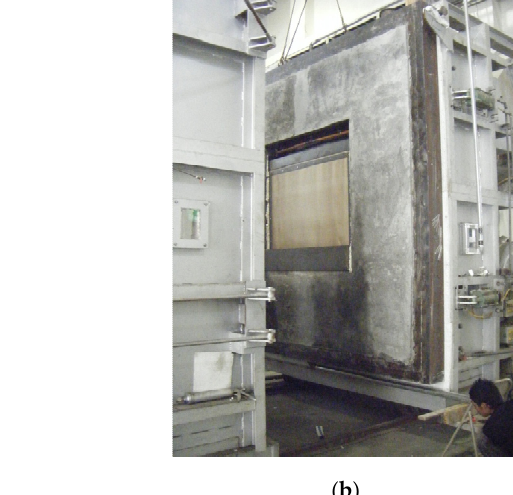
Figure 5. The schematic and images of the smoke-barrier system: ( a ) smoke-barrier system, and ( b ) smoke-barrier testing device.